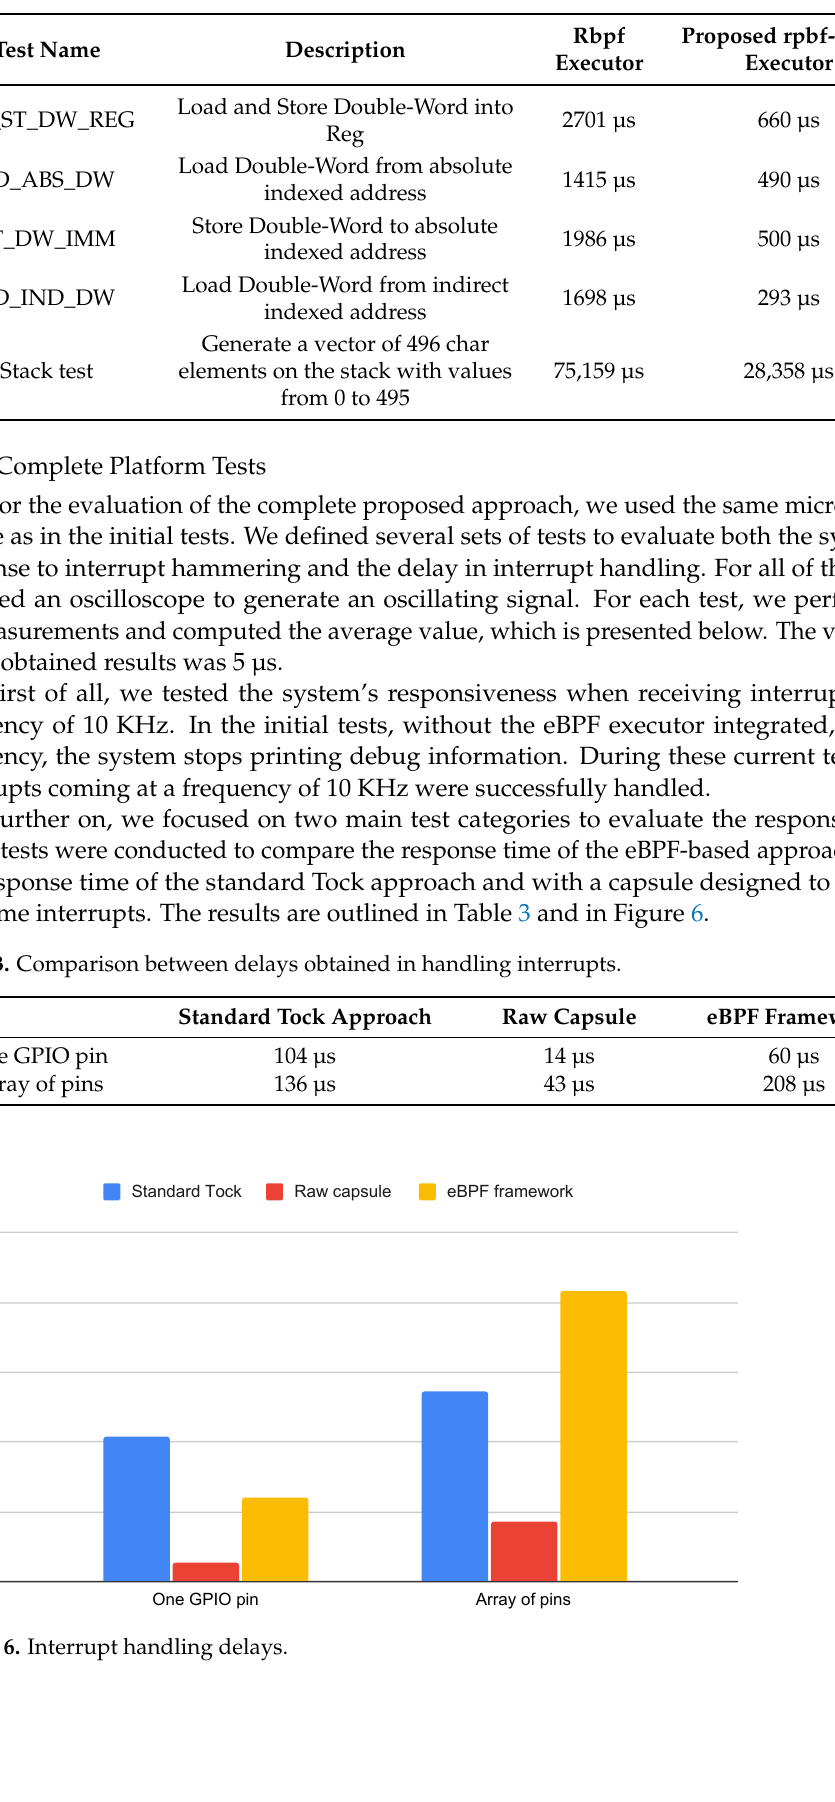
Table 2. Load and store operations execution speed comparison between the rbpf executor and the proposed executor.